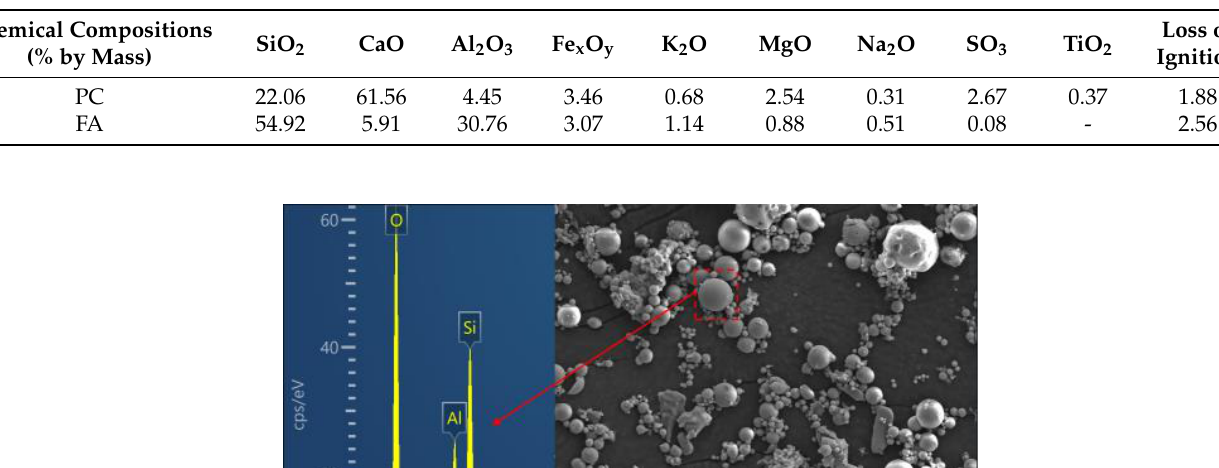
Table 1. Chemical compositions of Portland cement and FA.